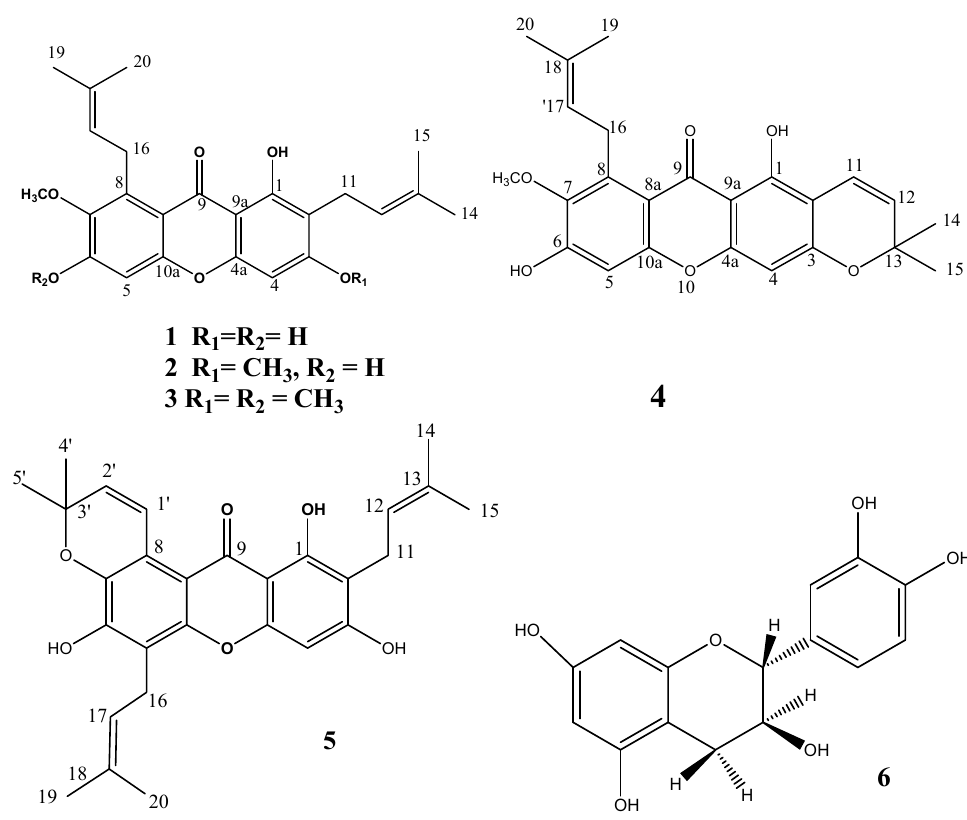
Figure 1. Structures of compounds 1 – 6 .